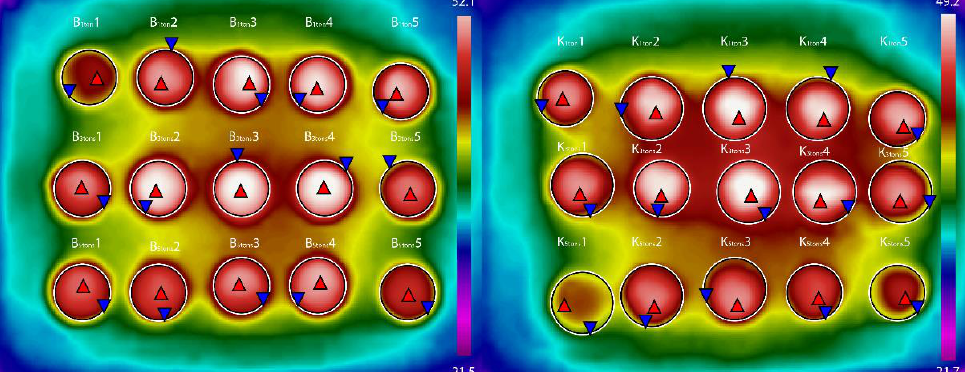
Figure 4. Examples of thermograms recorded during the cooling phase of bentonite ( left ) and kaolin ( right ) samples, in which is possible to observe the inhomogeneous cooling of the disks, where samples located at the centre (red triangles) show higher temperatures than those at the borders (blue triangles).